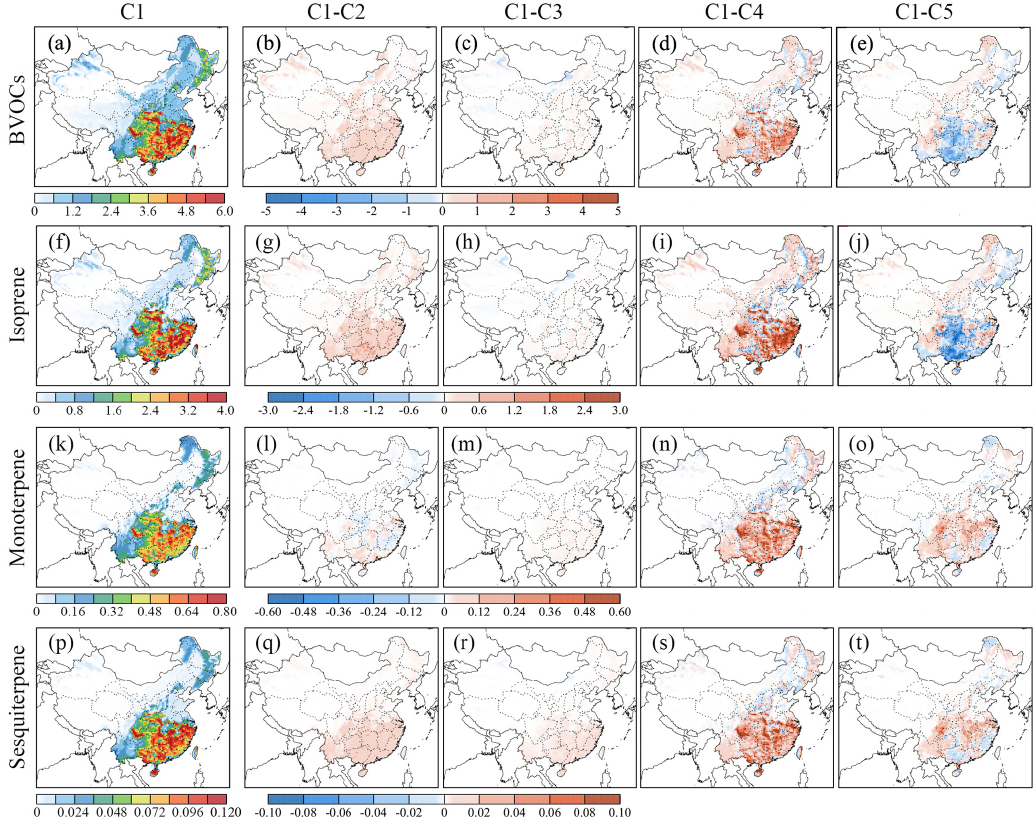
Figure 4. Comparison of three main BVOC species in different cases in summer (June, July, and August). (a, f, k, p) C1, (b, g, l, q) C1–C2, (c, h, m, r) C1–C3, (d, i, n, s) C1–C4, and (e, j, o, t) C1–C5. Unit is milligrams per square meter per hour (mgm − 2 h − 1